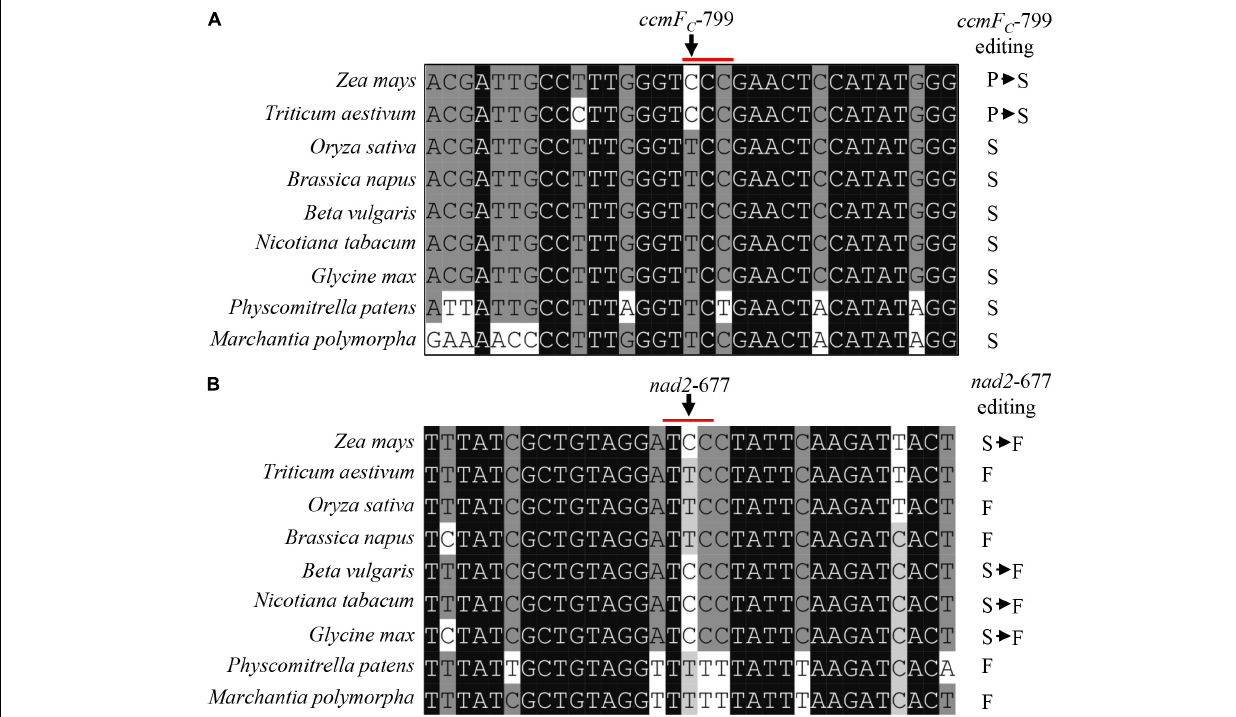
FIGURE 5 | The amino acid residues encoded by ccmF C -799 and nad2 -677 in multiple species. (A,B) Alignment of the neighboring gDNA sequences of ccmF C and nad2 . The gDNA and cDNA sequences were derived from GenBank/EST and GenBank/EMBL databases. The abolished editing sites in the emp17 mutant are arrowed.